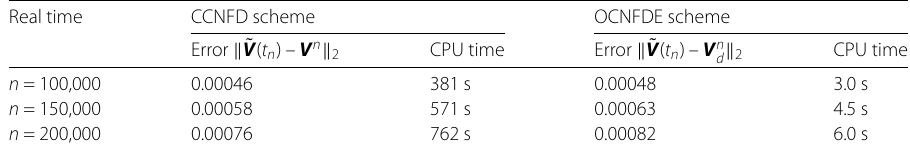
Table 1 Comparisons of errors and CPU time of the CCNFD and OCNFDE solutions Real time CCNFD scheme OCNFDE